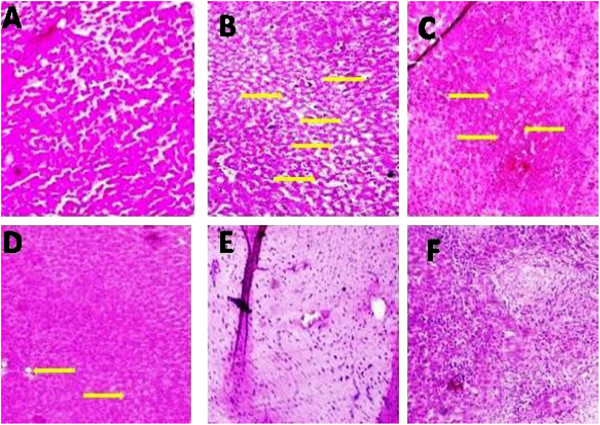
Umbelliferone β-D-galactopyranoside (UFG) effect on liver in different groups of rats: (A) Normal control: Normal control group did not produce any changes in histopathology (B) Diabetic control: Diabetic control group rat shown enlarged of micro droplet of fat (yellow arrow) (C) UFG I (10 mg/kg): Treatment with UFG dose (10 mg/kg) shown some part having micro droplet of fat deposition (yellow arrow). (D) UFG II (20 mg/kg): Treatment with different dose UFG (20 mg/kg) shown few particle of micro droplet of fat in liver histopathology (yellow arrow). (E) UFG III (40 mg/kg): Histopathology of UFG (40 mg/kg) drug not showing any fat deposition and other assortments. (F) Glibenclamide (10 mg/kg): Standard drug treated group shown histopathology similar to the normal control groups. The samples were obtained from the same liver anatomical regions. For each group, 6 rats were examined and 80 pictures were taken. The above picture for each group was chosen randomly from the 80 pictures in this group. Original magnification, 10 × .